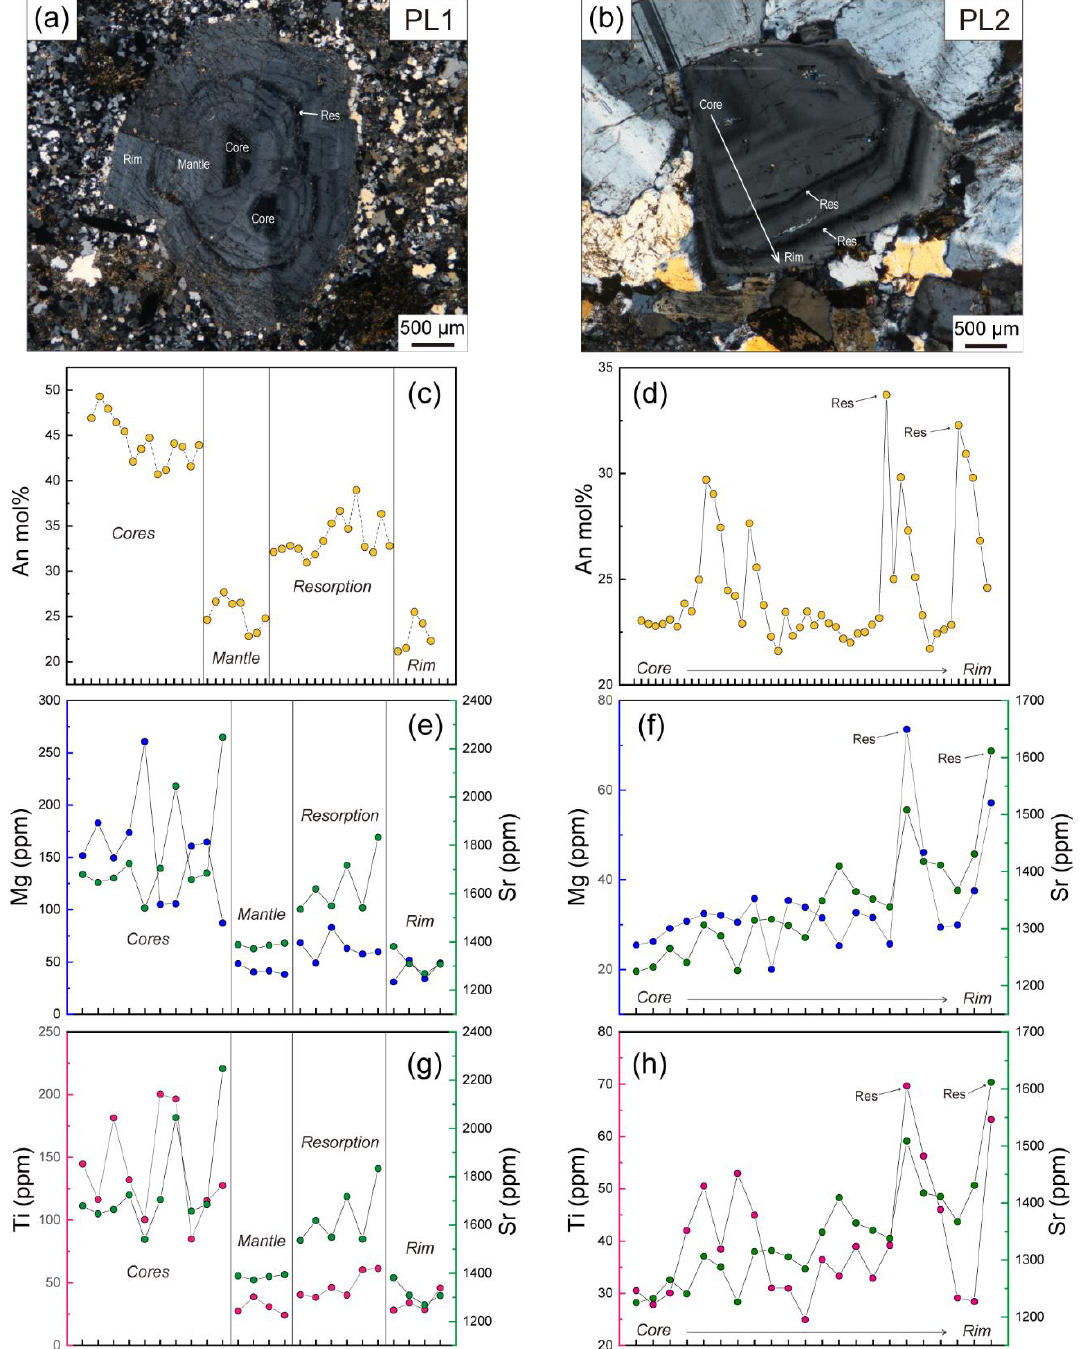
Figure 8. Cross-polarized micrographs and compositional profiles of the PL1 and PL2 plagioclase phenocrysts. ( a ) Core-mantle-rim pattern in the PL1 crystal; ( b ) Oscillational zoning pattern in the PL2 crystal; ( c , d ) Compositional profiles showing the variation of anorthite in the PL1 and PL2 crystals. Double-Y diagrams showing the variation of magnesium and strontium ( e , f ), and titanium and strontium ( g , h ) contents in the PL1 and PL2 crystals. The white line in ( b ) shows the profile line of EPM and LA-ICP-MS analyses.